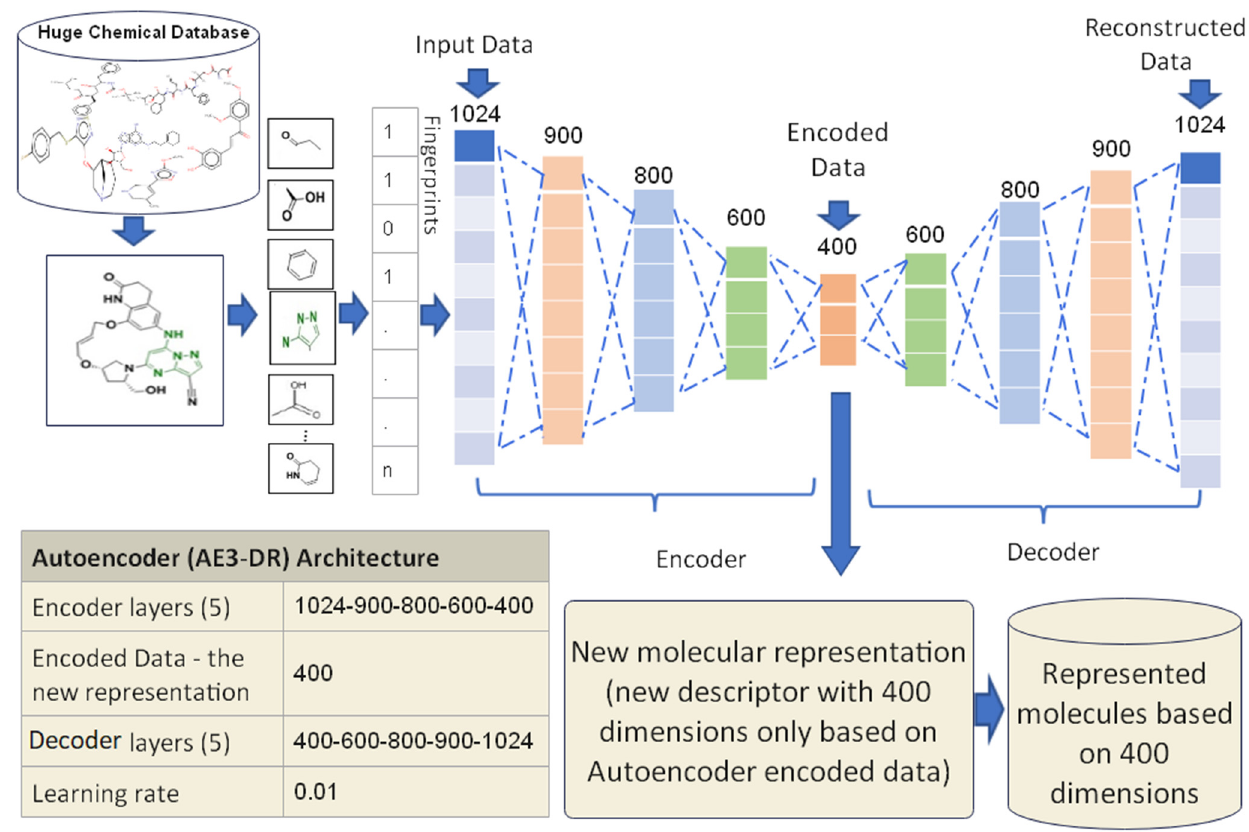
Figure 6. The AE3-DR proposed Figure 7. The AE3-DR proposed design.